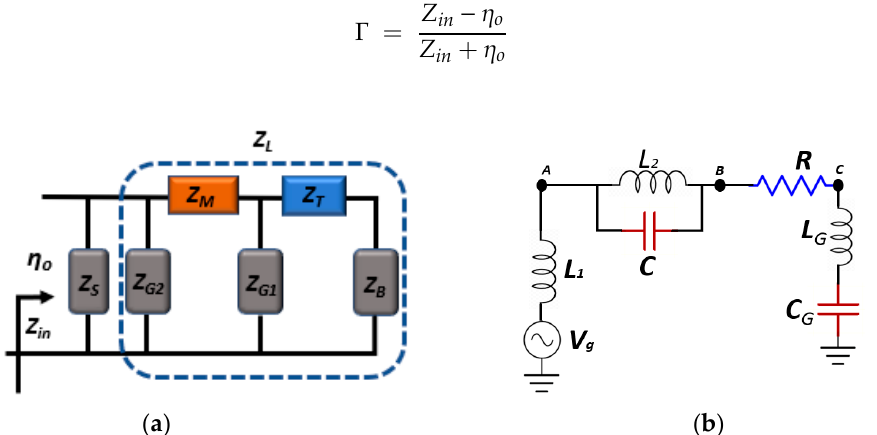
Figure 4. ( a ) Transmission line model of the graphene-metal antenna; ( b ) Equivalent RLC resonant circuit model of the hybrid antenna derived from the corresponding transmission line model.